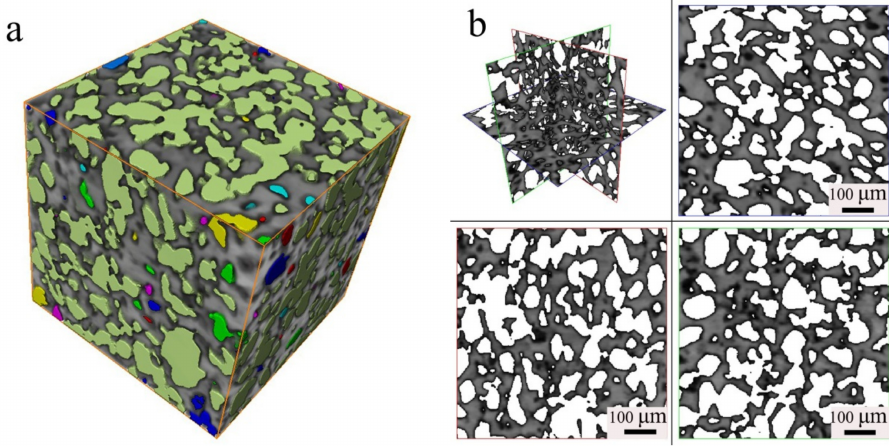
Figure 2. 3D Micrograph of the N1120-30-374 alloy: ( a ) Three-dimensional pore distribution ( b ) four views of pore distribution.